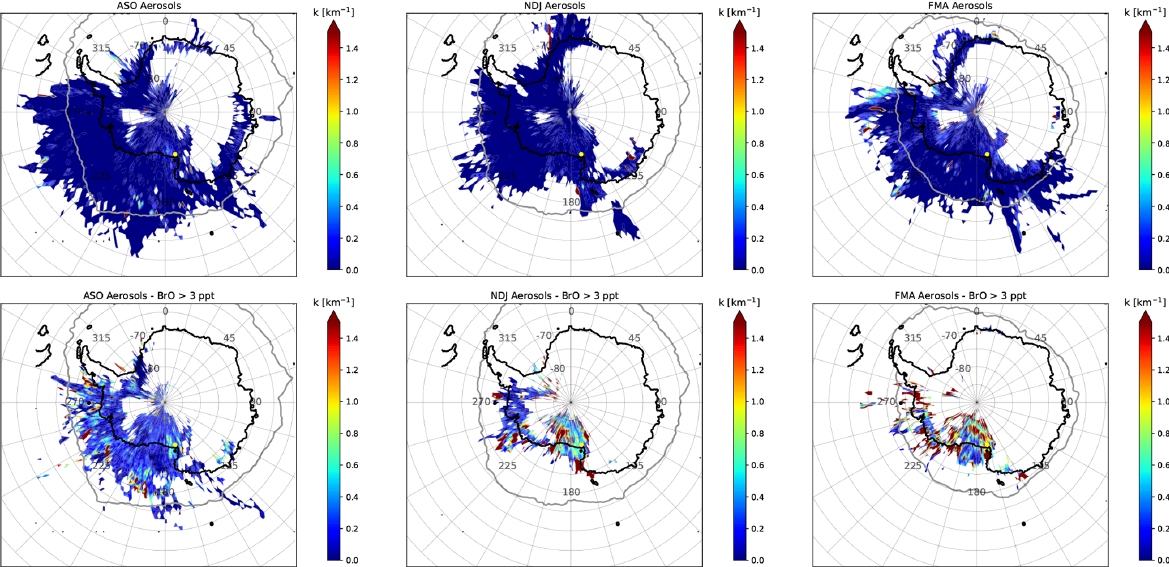
Figure 15. The same as Fig. 14 but for